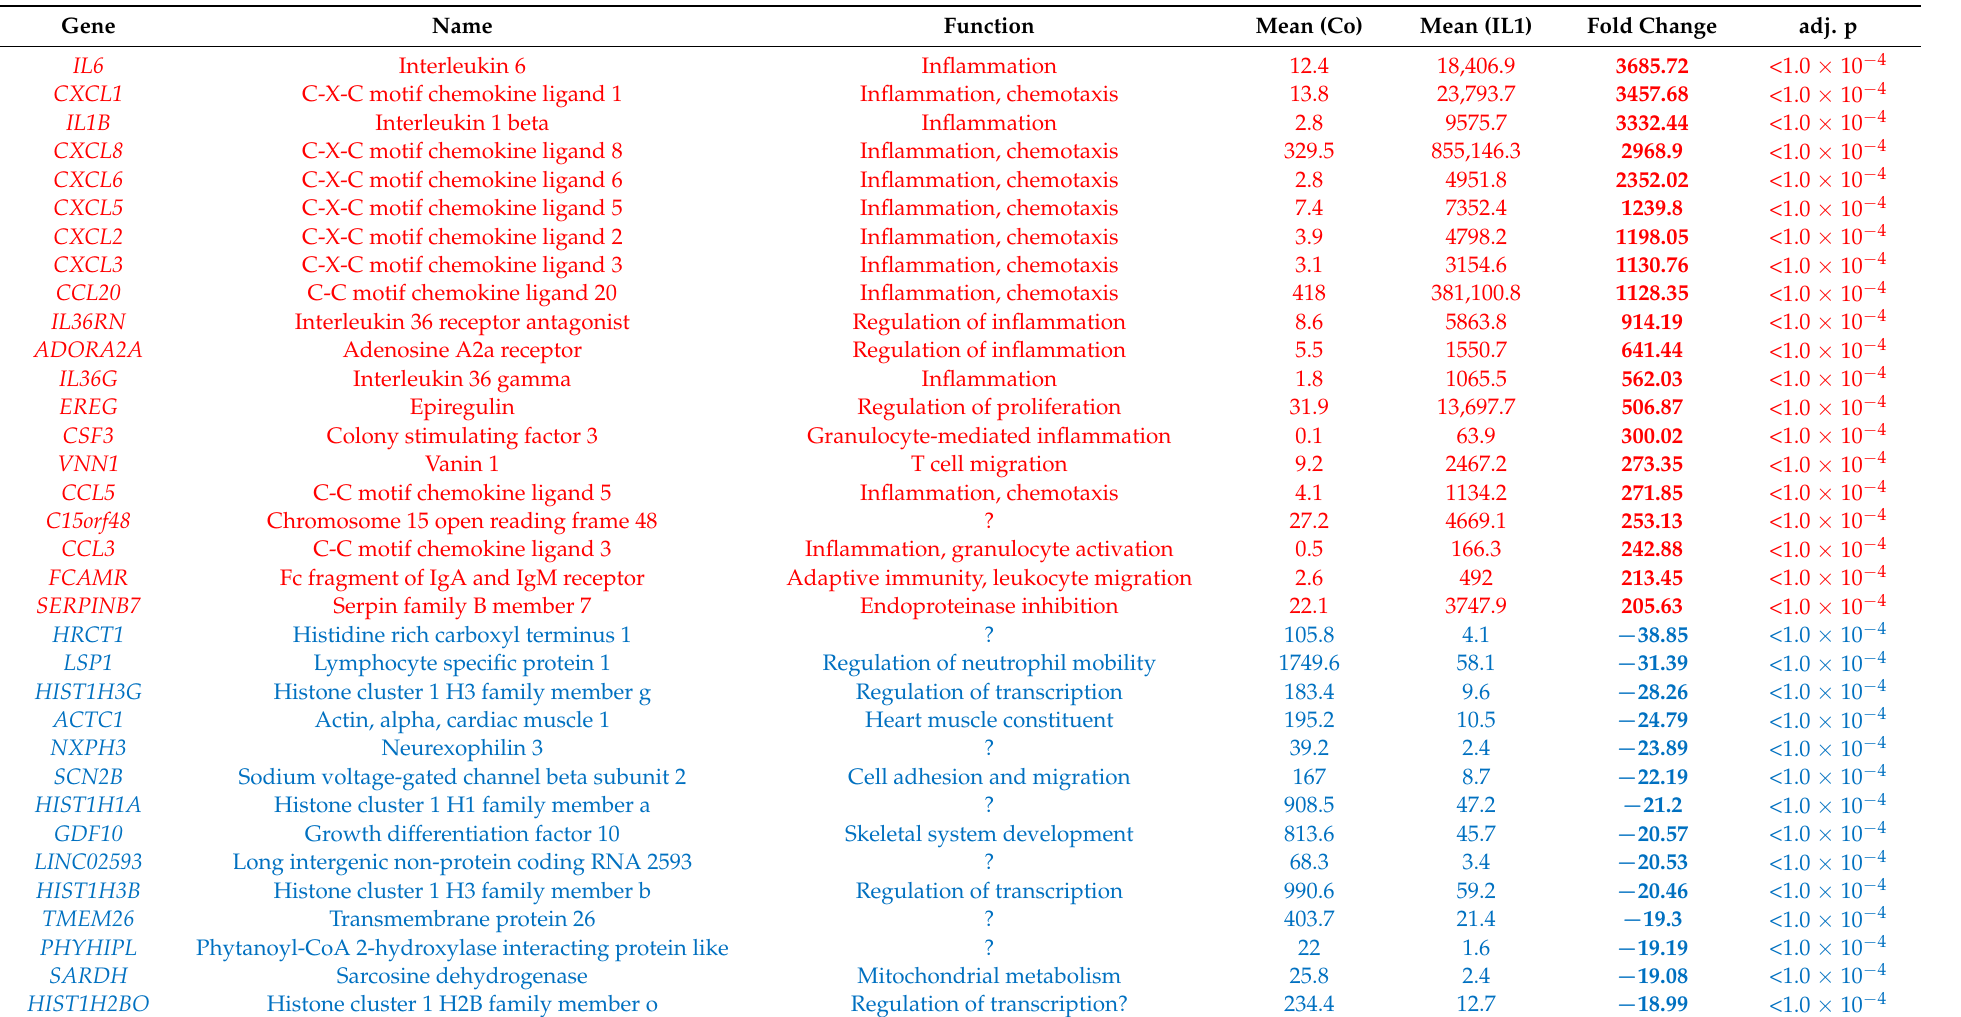
Table 1. Twenty most strongly up- and downregulated genes in interleukin 1-treated OA chondrocytes (IL1) relative to control